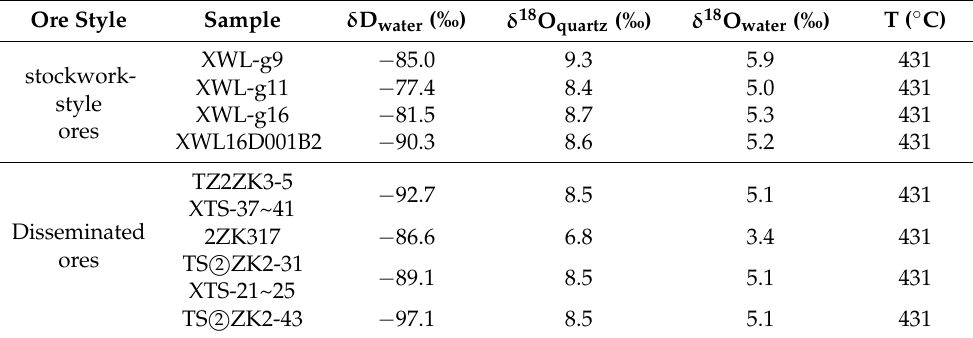
Table 3. The D-O isotopic composition of quartz in the Xiawolong gold